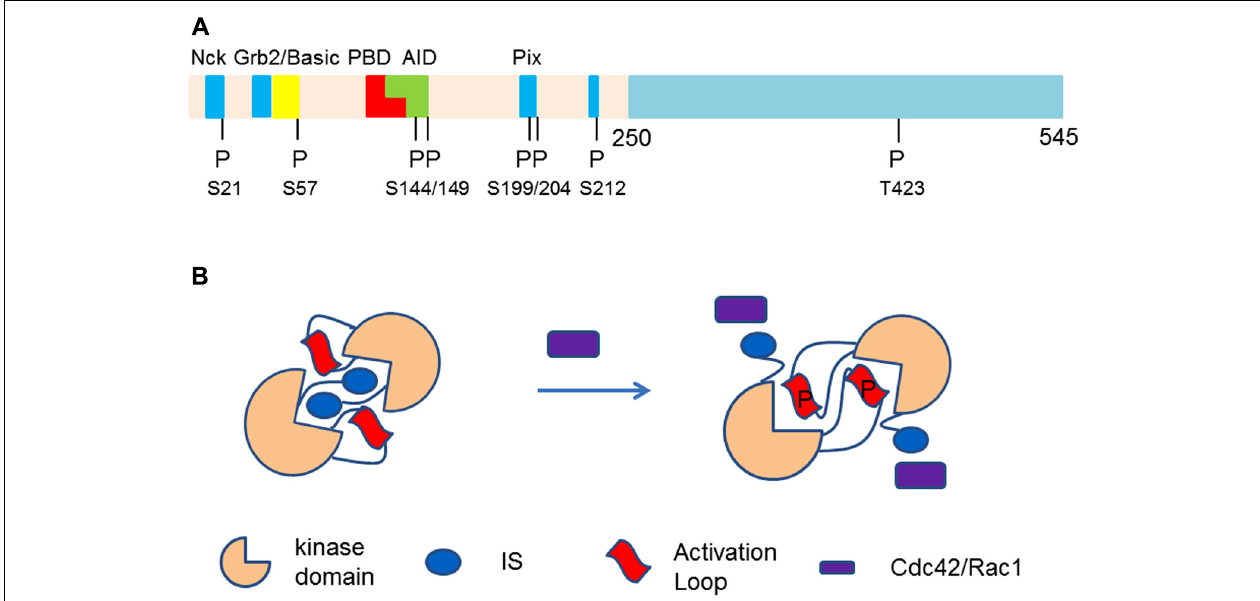
lies in the activation loop. (B) Activation of Pak1 by Cdc42/Rac1. Pak1 forms a homodimer, an auto-inhibitory configuration.The activation loop is dislocated from the catalytic center of Pak1 by autoinhibitory domain in inhibitory switch domain (IS, inhibitory switch).When Cdc42 or Rac1 binds to PBD domain, the IS is displaced from its inhibitory position and auto-phosphorylation on activation loop